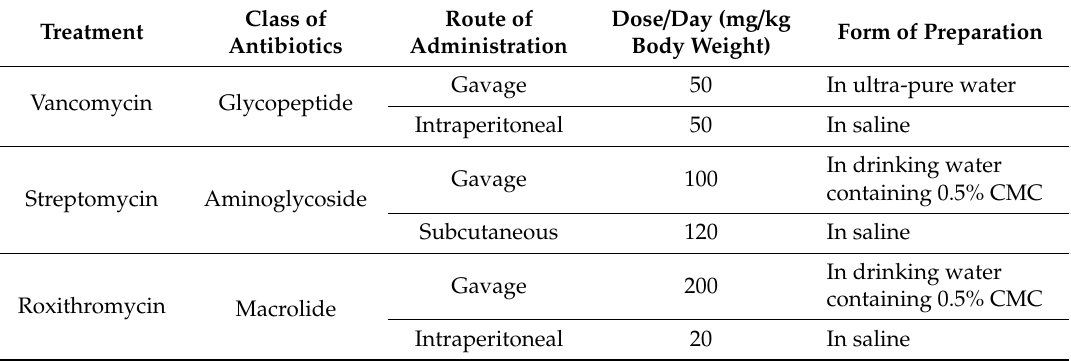
Table 2. Compounds used, class of antibiotics, routes of administration, dose levels and form of preparation.